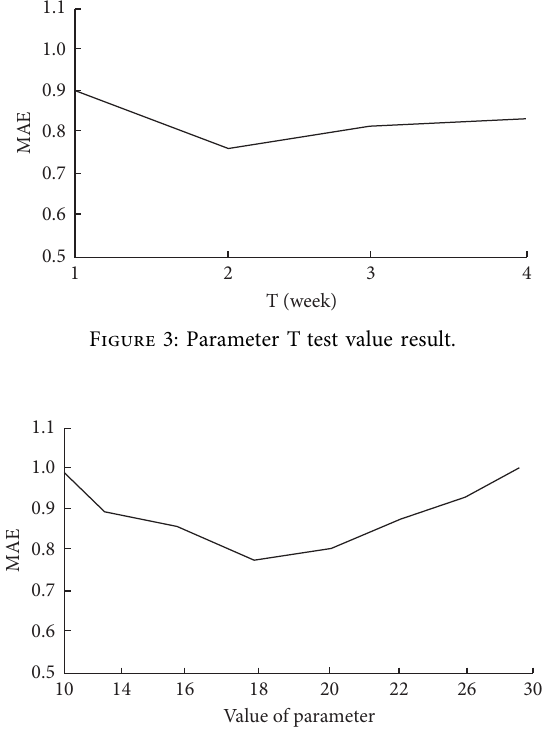
Figure 4: Parameter δ test